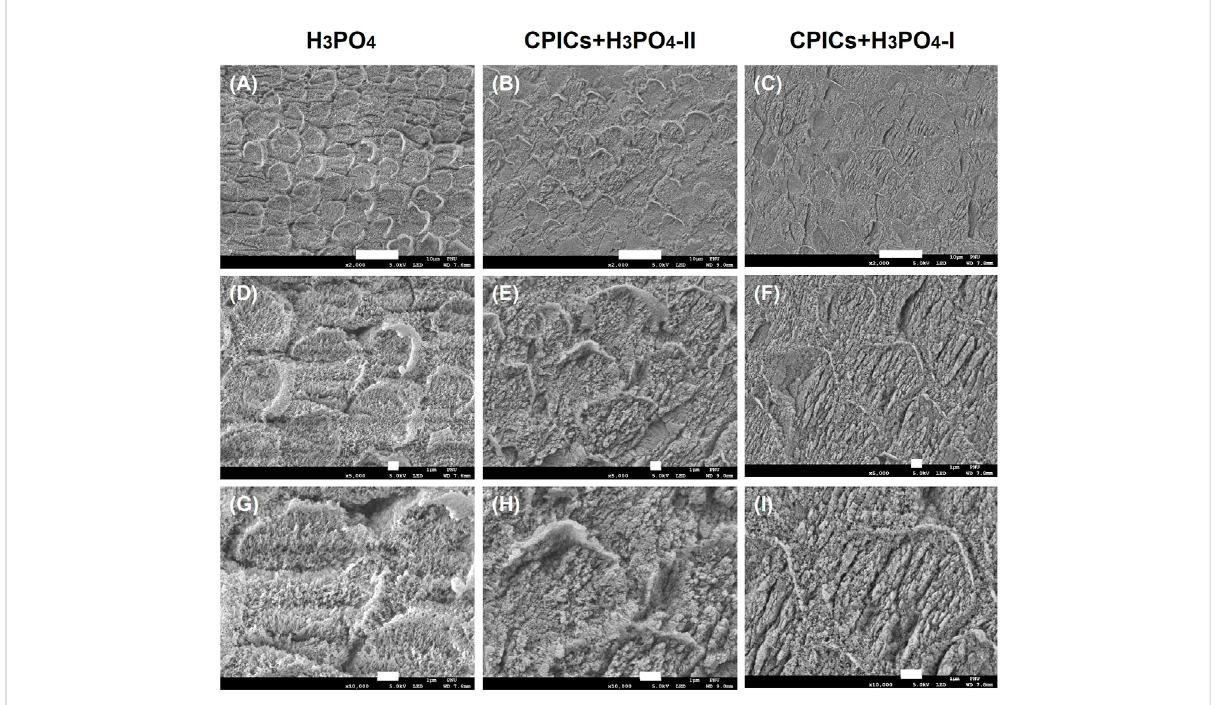
FIGURE 3 Scanning electron microscope images of the acid-etched enamel. Each row represents a different magni fi cation (2,000×; 5,000×; and 10,000×, respectively). (A,D,E) control (35% H 3 PO 4 ); (B,E,H) , CPICs+H 3 PO 4 -II; (C,F,I) , CPICs+H 3 PO 4 -I. Scale bars represent 10, 1, and 1 µm, respectively. The same results are shown at different magni fi cations (see each column)..